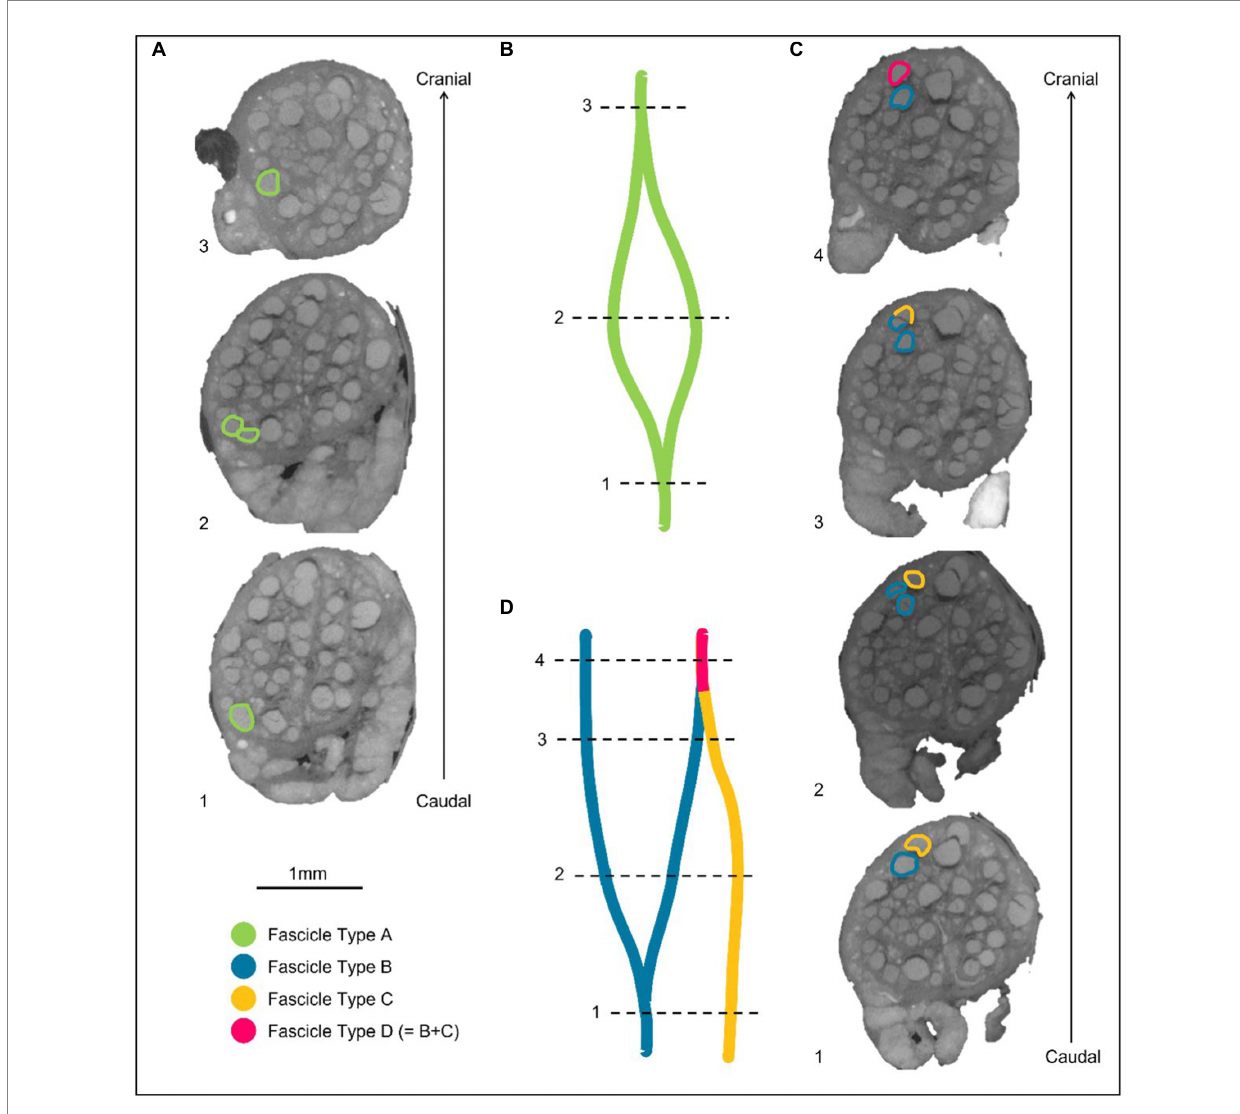
FIGURE 4 Labeling of fascicles across anastomoses. (A) An example of a fascicle type splitting and then merging back on itself or with a fascicle labeled as the same type. These fascicles are labeled as Fascicle Type A before splitting, while separate fascicles, and after merging. (B) A schematic of A in the longitudinal direction. (C) An example of two differently labeled fascicle types (Type B and C). The fascicle labeled in blue as Fascicle Type B splits into two fascicles. One of these fascicles subsequently merges with another fascicle type (Fascicle Type C) when proceeding proximally/cranially up